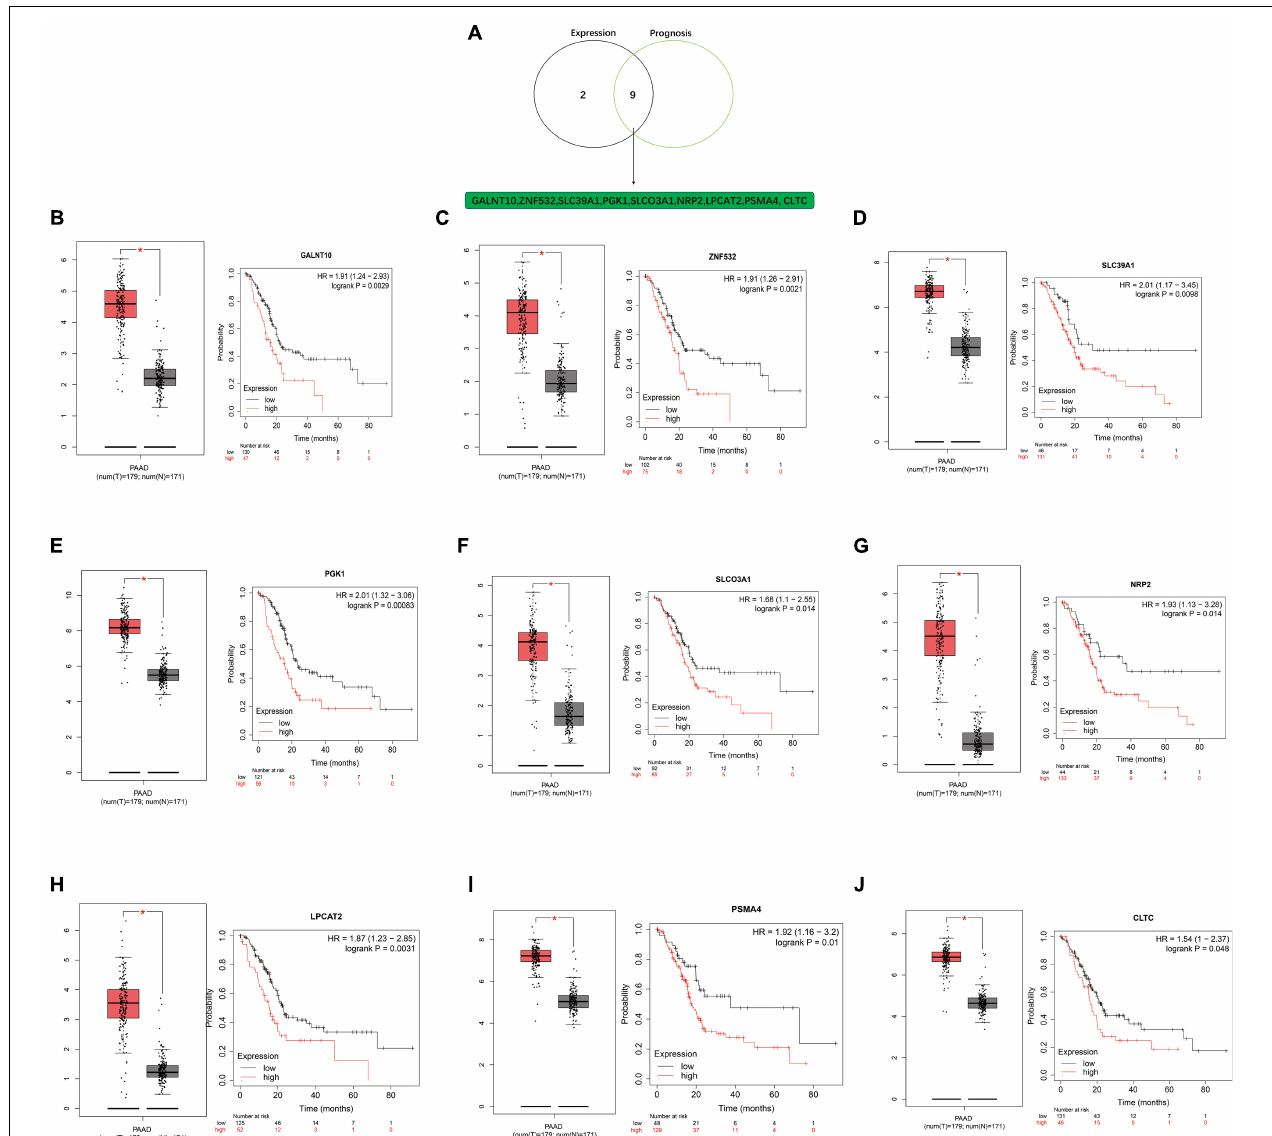
FIGURE 8 | Screening key mRNA (target genes) in PDAC. (A) Identification of key mRNAs among the 11 potential key mRNAs by combining expression and prognosis analyses using the GEPIA and Kaplan-Meier plotter databases. (B) Expression and prognostic value of GALNT10 in PDAC. (C) Expression and prognostic value of ZNF532 in PDAC. (D) Expression and prognostic value of SLC39A1 in PDAC. (E) Expression and prognostic value of PGK1 in PDAC. (F) Expression and prognostic value of SLCO3A1 in PDAC. (G) Expression and prognostic value of NRP2 in PDAC. (H) Expression and prognostic value of LPCAT2 in PDAC. (I) Expression and prognostic value of PSMA4 in PDAC. (J) Expression and prognostic value of CLTC in